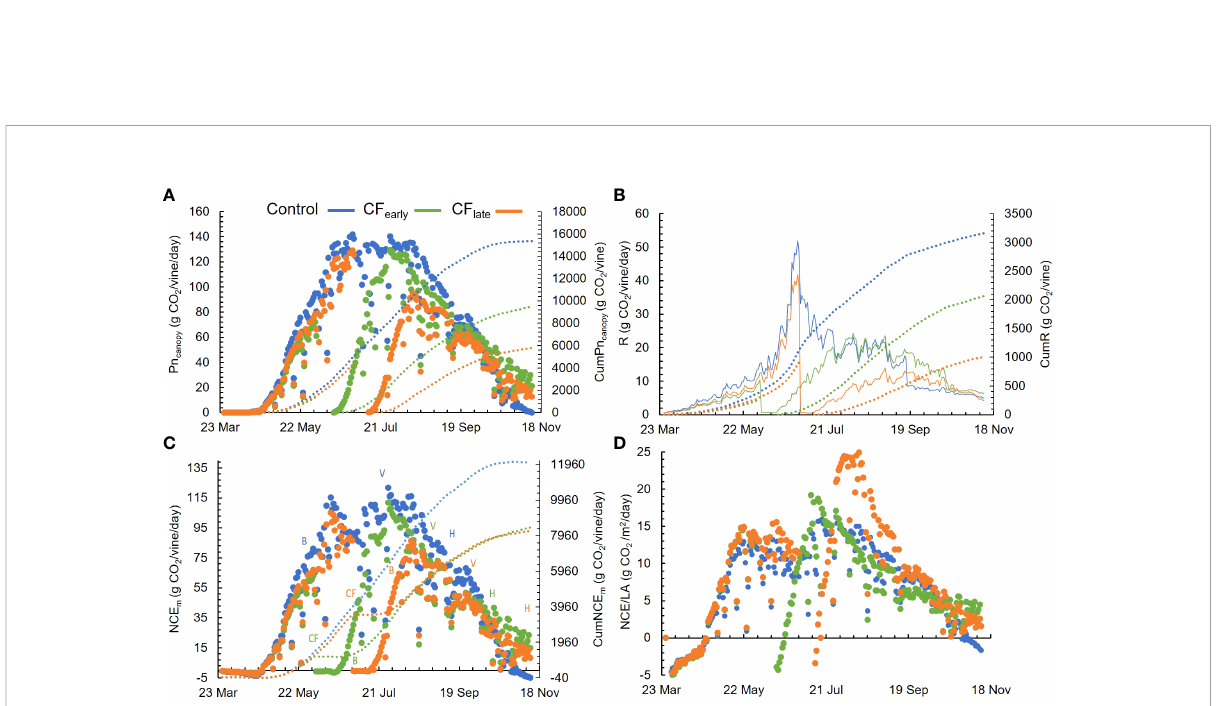
FIGURE 4 Seasonal patterns for daily modelled whole-canopy net photosynthesis (Pn canopy ) and cumulative Pn canopy (CumPn canopy ) (A) , daily (R) and cumulative (CumR) above ground modelled respiration (B) , daily (NCE m ) and cumulative (CumNCE m ) net carbon exchange (C) and daily modelled NCE m per unit of leaf area (NCE/LA) (D) . B, bloom; V, veraison; H, harvest. Dotted lines represent the cumulated parameters. Blue, green, and orange colours correspond to the Control, CF early and CF late treatments. Each plot is the average of modelling four vines for each treatment in